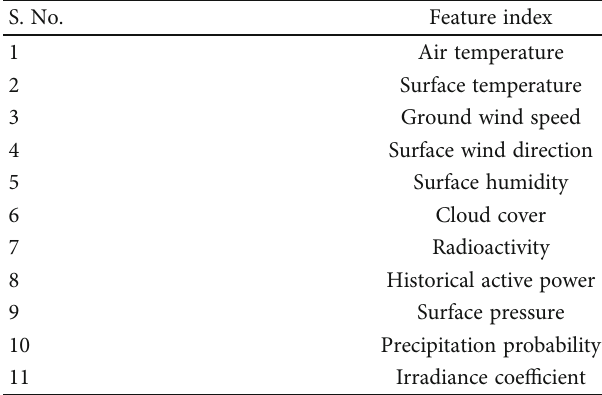
Table 2: Attributes of sample data.